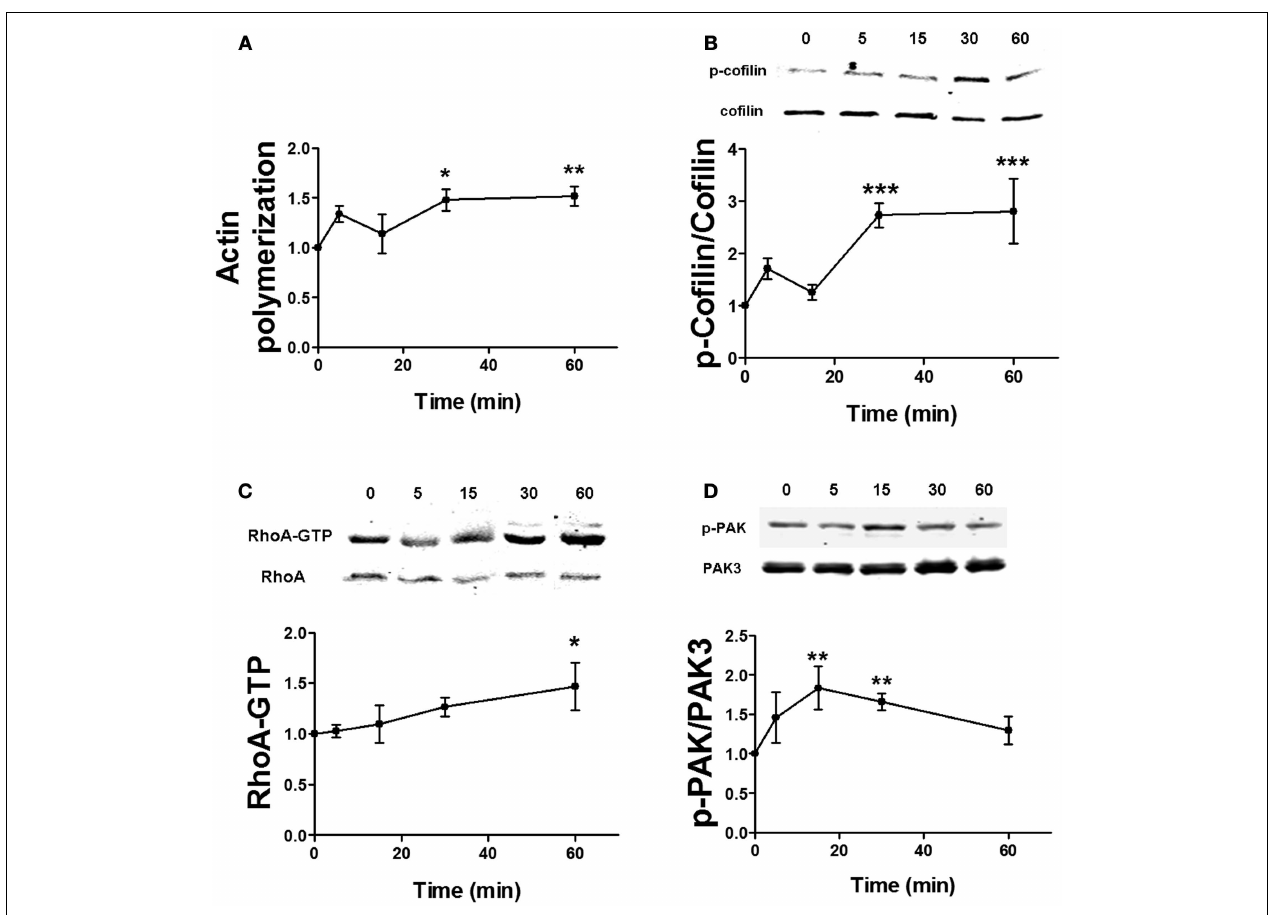
were homogenized and either processed for western blot (B,D) or pulled-down with RBD-bound agarose beads and then processed for western blot (C) . Data are presented as the ratio (fold of control) of: (B) phospho-cofilin (p-cofilin) over total cofilin ( N = 4–8), (C) RhoA-GTP over total RhoA ( N = 14–16), (D) phospho-PAK (p-PAK) over total PAK3 ( N = 2–8); * p < 0.05, ** p < 0.01, *** p < 0.001, as compared with control (0min) (one-way